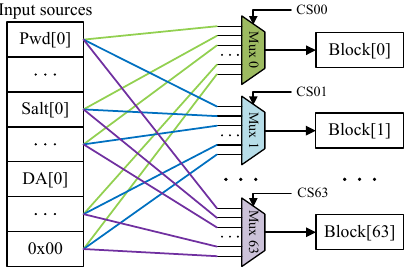
Figure 11: Data path between the input sources and the output